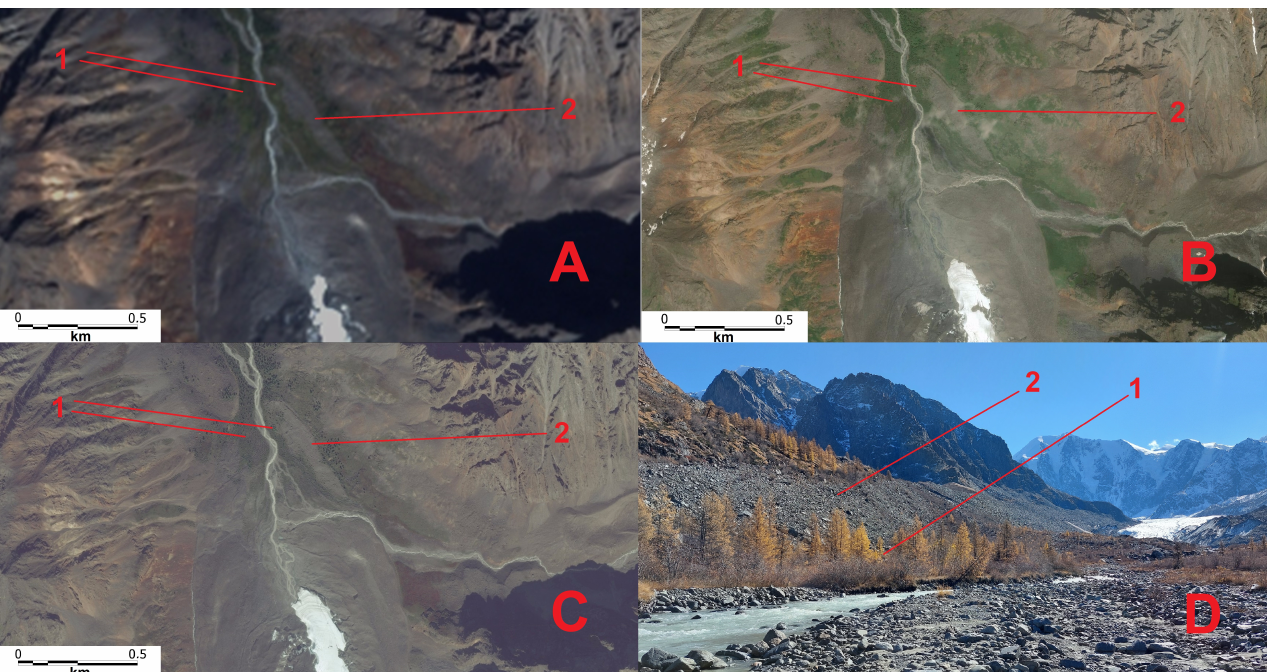
Figure 4. The LIA complex of the Bolshoi Maashei glacier: ( A ) Sentinel-2 image (2021-09-08), ( B ) World View 02 (2013-08-24), ( C ) GeoEye-1 (2016-07-01), ( D ) photography of the LIA complex taken from its lowest point. 1—trees, growing on the LIA moraine; 2—LIA lateral